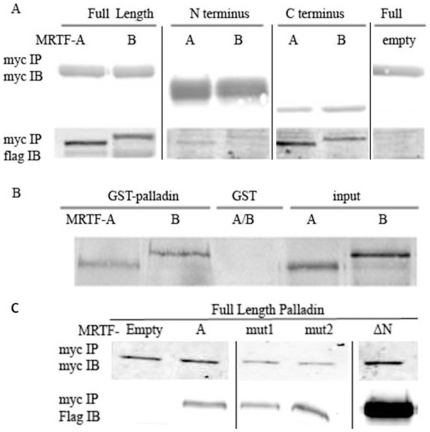
Carboxyl terminus of palladin interacts with MRTFs in SMCs.A) Full length, amino (N), or carboxyl (C) terminus of myc tagged palladin constructs were cotransfected with flag tagged MRTF-A or B into HEK-293 cells. Co-IP assays were performed, and proteins were detected with myc and flag antibodies. Note that different regions of the gels are shown for full length, and the N- and C-termini, which as expected, run differently, as shown in Fig. 2C. B) in vitro pull down assays showed that MRTF-A interacts with palladin directly. Recombinant GST tagged palladin was purified from E.Coli and MRTF-A and –B proteins were translated in vitro. C) MRTF-A interaction with palladin is not via the amino terminal RPEL domain. The two RPEL motifs (mut1: R33A and P34A and mut2: L39A and V40A) mutants and an amino terminal 100 aa deletion of MRTF-A (ΔN) were cotransfected with myc tagged palladin into HEK-293 cells, and co-IP was performed 36 h after transfection with anti-myc antibody and blotted with anti-myc or flag antibodies.